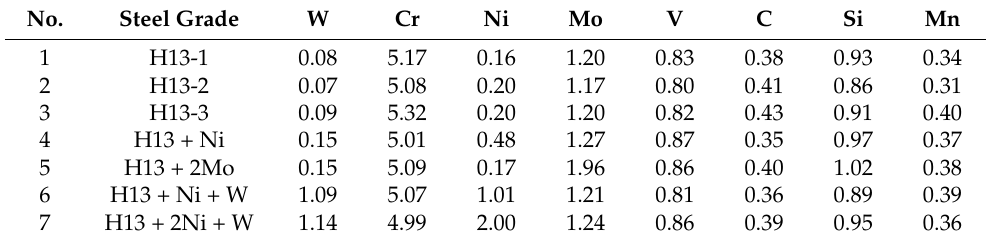
Table 4. Contents of alloying elements in the ingots (wt%).